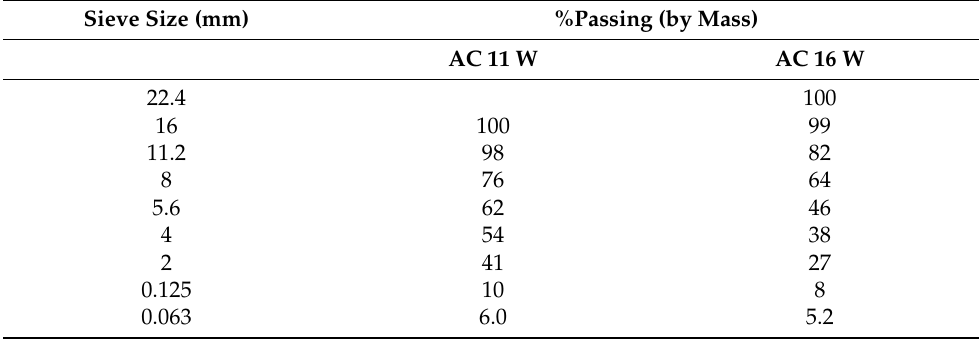
Table 3. Mineral gradation of the asphalt mixtures.